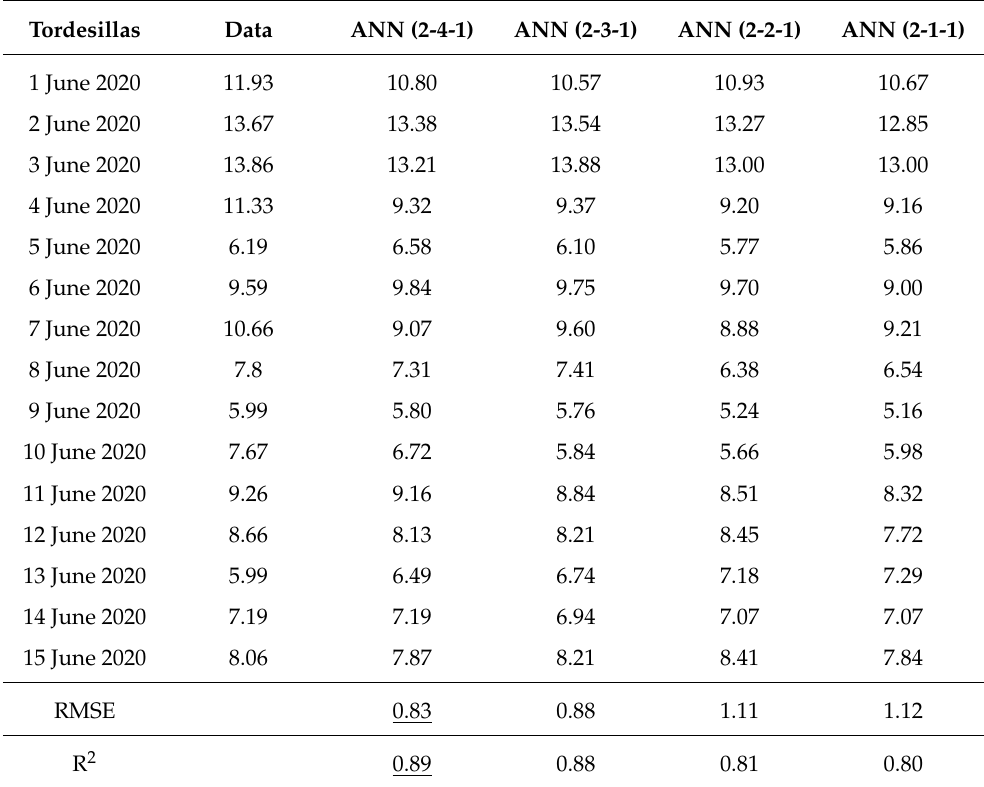
Table 4. Daily minimum temperature ( ◦ C) in Tordesillas (Valladolid) measured for 15 days (i.e., 1–15 June 2020), estimated with the neural architectures varying the number of neurons from four to one in the hidden layer (i.e., ANN (2-4-1), ANN (2-3-1), ANN (2-2-1) and ANN (2-1-1)), and fitting of the